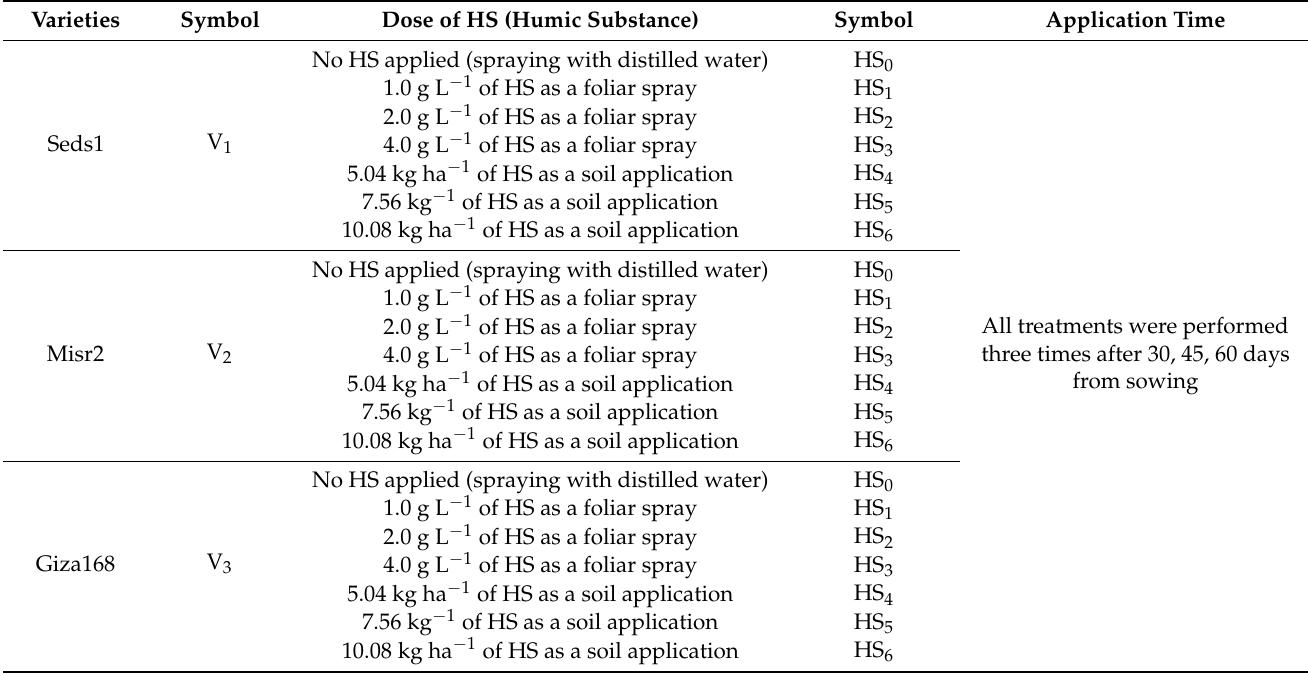
Table 2. The description of the experimental treatments.